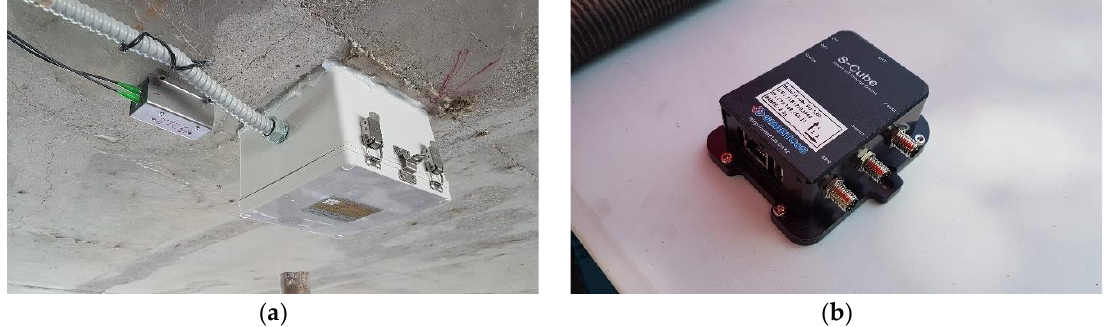
Figure 5. Accelerometers: ( a ) installation on site; ( b ) shape of sensor.